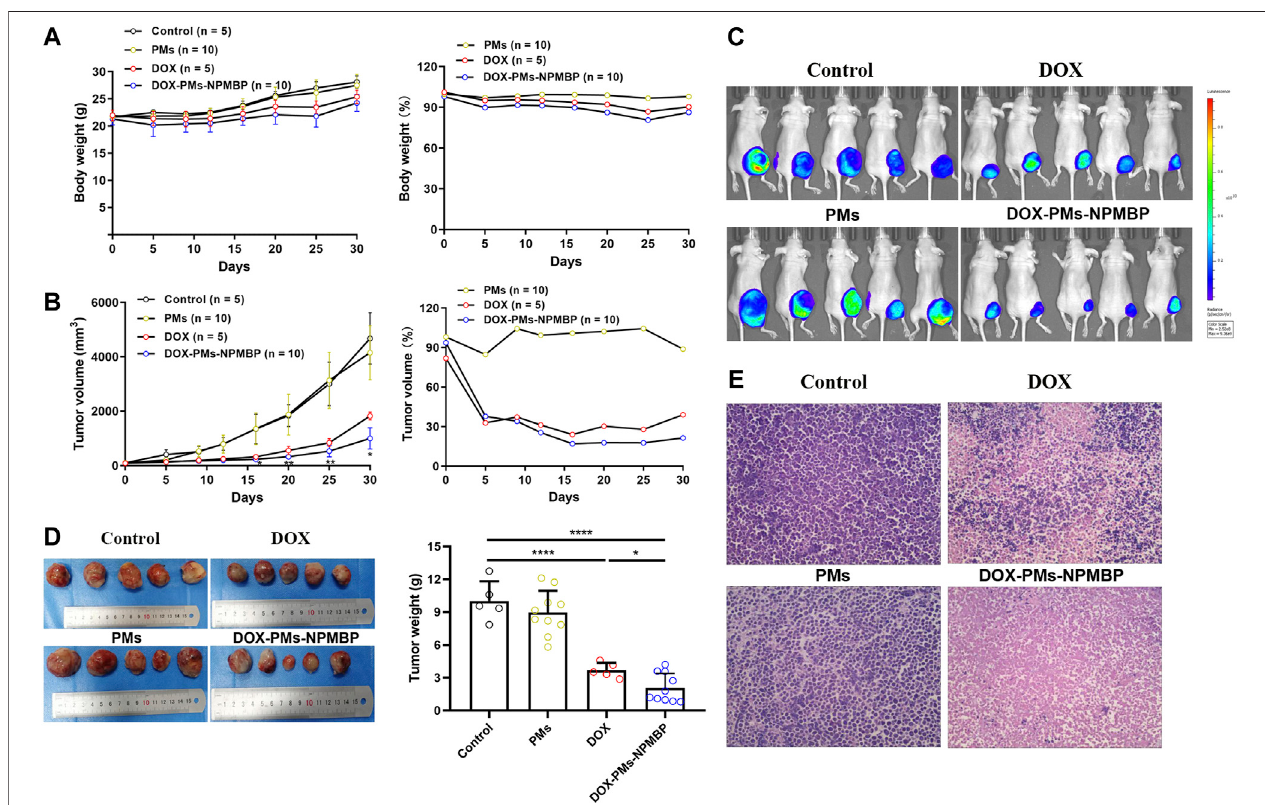
FIGURE6 | DOX-PMs-NPMBPinhibits xenograftgrowth and enhances antileukemia activity inNalm6-Luc/DOX xenograftnude mice. Thenude mice with Nalm6- Luc/DOX xenografts were randomly divided into four groups and intraperitoneally administered DOX, DOX-PMs-NPMBP, PMs, or PBS once daily for 3 days. Body weights and tumor size were measured at the indicated time scheme by a caliper (tumor volume (cid:2) shortest diameter 2 × longest diameter/2). (A) Body weight during follow-up.Therelativelevelsofbodyweightarerepresentedaspercentagechangesfromvehiclecontrollevels,whichweresetat100%. (B) Tumorvolumeateach timepoint. Therelativelevelsoftumorvolumearerepresented aspercentage changesfromvehiclecontrollevels,whichweresetto100%.* p < 0.05,** p < 0.01vs.DOX group. (C) Representativeofwhole-bodyluciferasereporterimagesfromvehicle,DOXorDOX-PMs-NPMBPtreatedmice. (D) Representativeofphotographsoftumors excised from xenograft mice after completed the study. The tumor weight was measured. * p < 0.05, **** p < 0.0001. (E) Hematoxylin-eosin-stained sections of tumor tissue from representative control and treated mice.